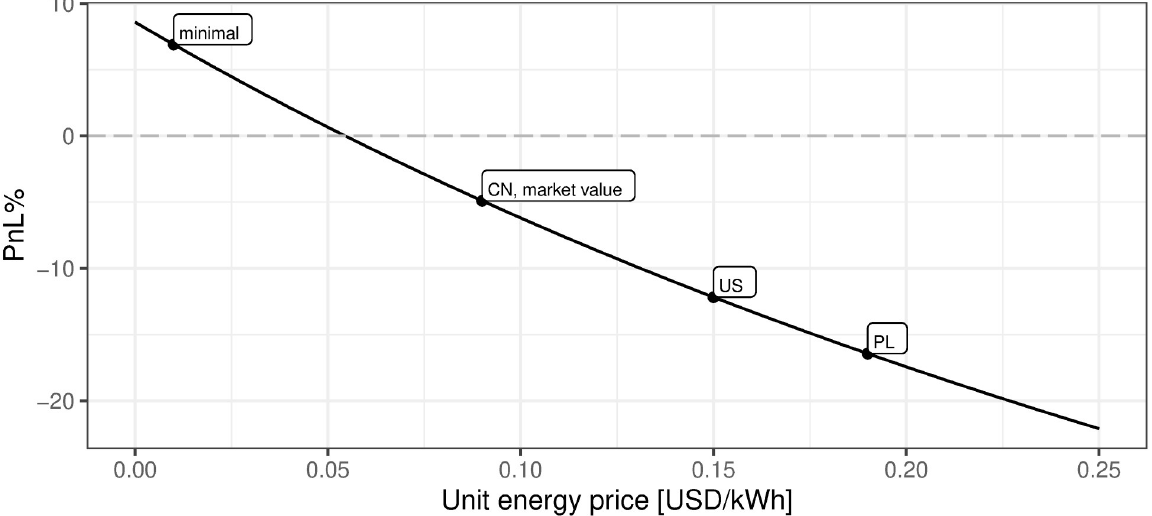
Fig 23. BTC mining profitability (PnL%) for different prices of electricity. Note: PnL%, calculated according to the formula 6. Hypothetical electricity prices range from 0 to 0.25 USD per kWh. Minimal, CN, PL, and US define respectively minimal world energy level, China, Poland, and US located mining profitability corresponding to the local energy cost, provided that remaining parameters are equal. The market value point describes the current state of market mining efficiency assuming the parameter outlined in the section Values of variables as of 2021/12/03, where energy cost is assumed to be 0.09 USD per kWh. Source: own calculations based on data described in section Crucial assumptions and data.